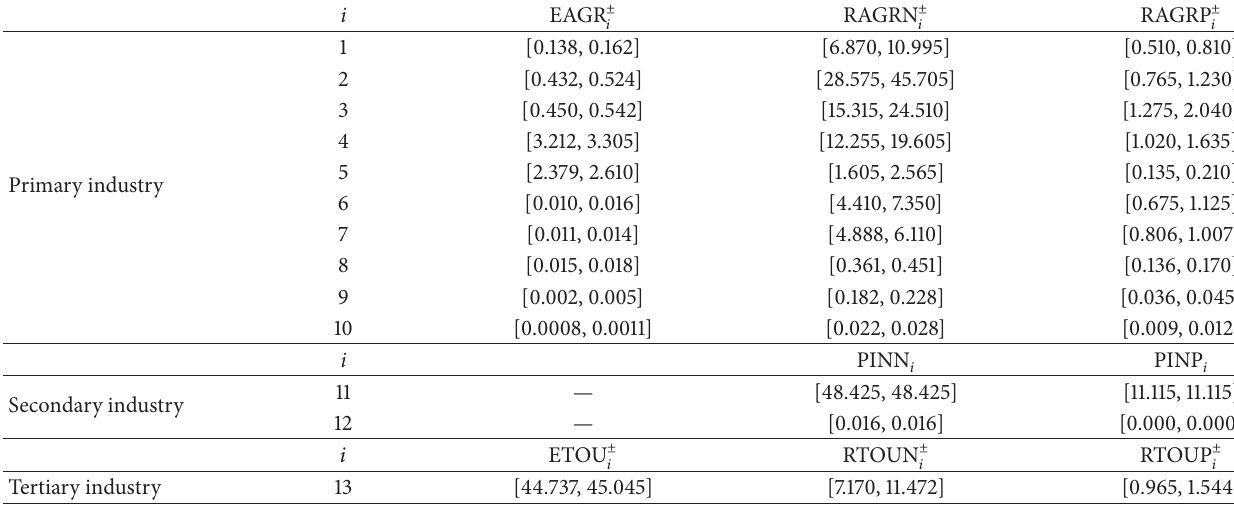
Table 1: Parameter values of ILP